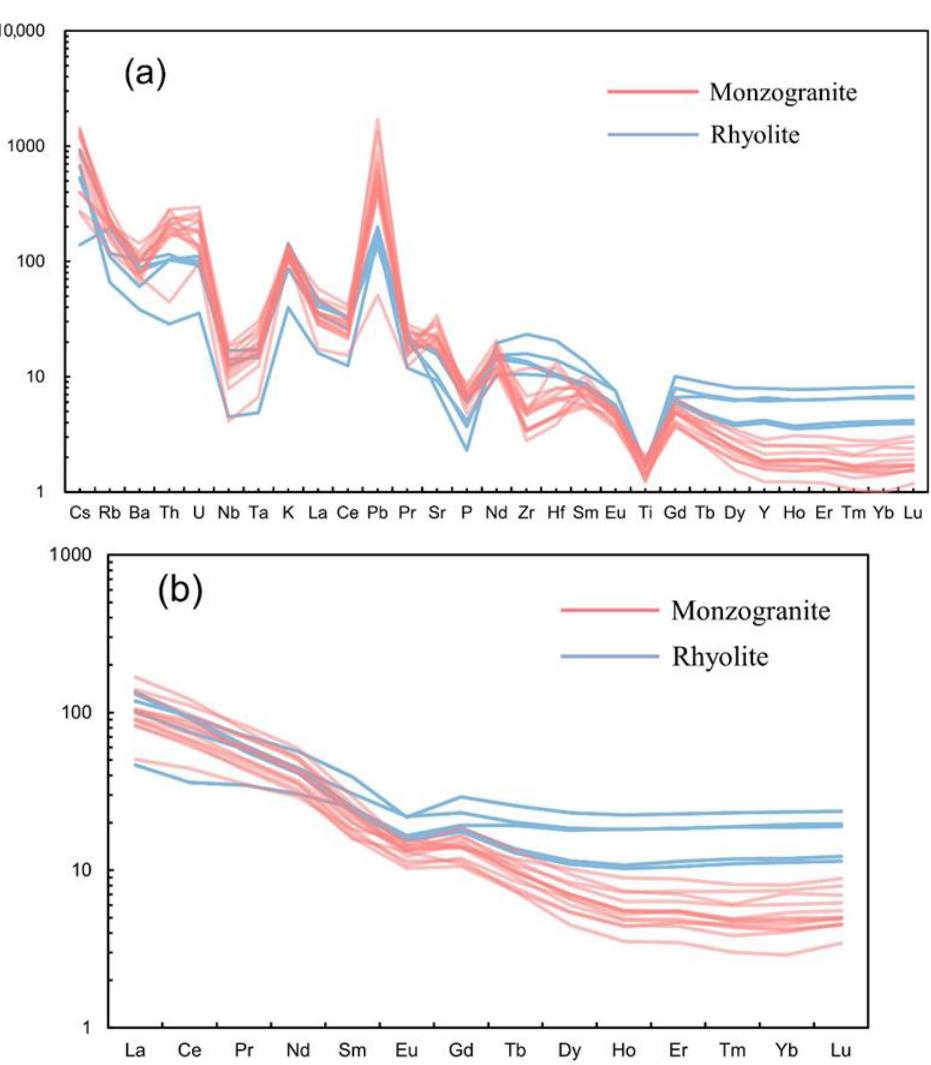
Figure 5. Primitive-mantle-normalized trace element ( a ) and chondrite-normalized REE ( b ) variation diagrams for samples from the Demingding deposit [42].